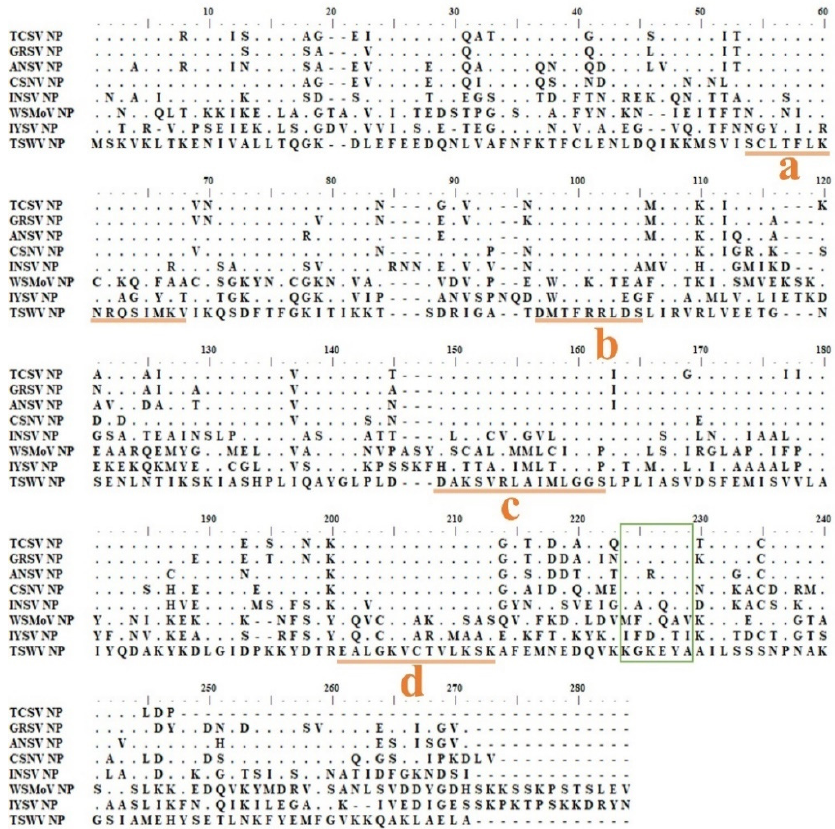
Figure 2. Amino acid sequence alignment of NP proteins from five TSWV serogoup members of the Euro-America type orthotospoviruses. The NP sequences of the tomato chlorotic spot virus (TCSV) (HQ634664), the groundnut ringspot virus (GRSV) (AF251271), the alstroemeria necrotic streak virus (ANSV) (GQ478668), the chrysanthemum stem necrosis virus (CSNV) (JQ764839), the impatiens necrotic spot virus (INSV) (D00914), the watermelon silver mottle virus (WSMoV) (NC003843), the iris yellow spot virus (IYSV) (NC029800) and the tomato spotted wilt virus (TSWV) (L12048) were aligned by ClustalW. Four continuous conserved domains with 100% aa identity ( a – d ) are indicated and underlined. A highly conserved domain in the C-terminal region is presented with a square.